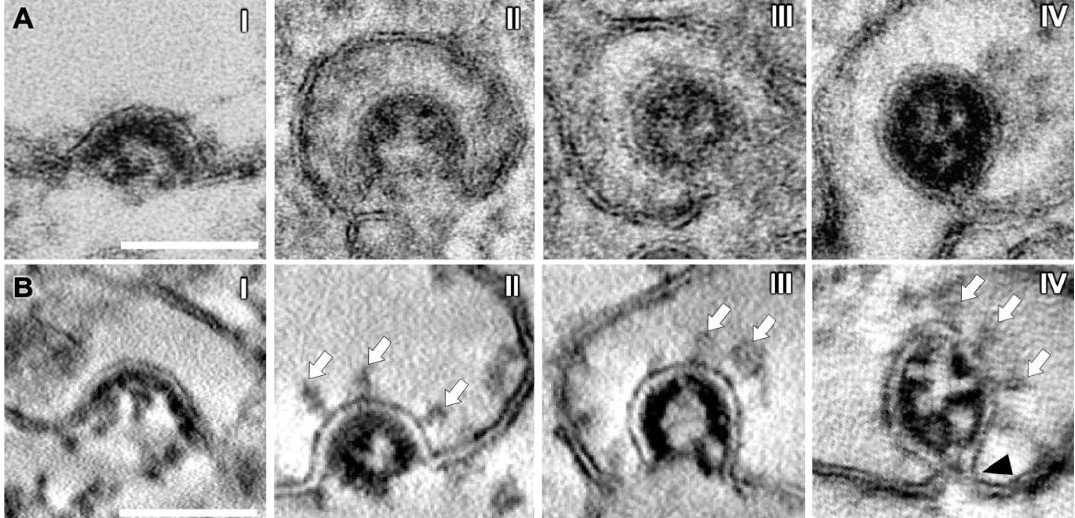
Figure 4. Consecutive stages of SARS-CoV-2 virion assembly. ( A ) TEM images. ( B ) Virtual sections (thickness ~10 nm) generated by STEM tomography. ( I ) N-packaged viral genome clusters at the cytoplasmic membrane face, accompanied by membrane curvature. ( II ) With increasing membrane curvature, the budding event is driven forward, until the membrane profile appears as an Omega shape ( III ). ( IV ) Virions shortly before membrane scission, still connected to the SMV membrane (black arrowhead). Note the improved visibility of the viral ribonucleoprotein (vRNP) lining the inside of the forming virion, the prominent S proteins (white arrows) and the optimal visibility of membrane profiles in the STEM virtual sections. Scale bars, 100 nm.